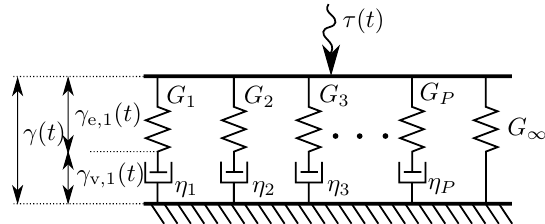
Figure 1. Generalised Maxwell constitutive